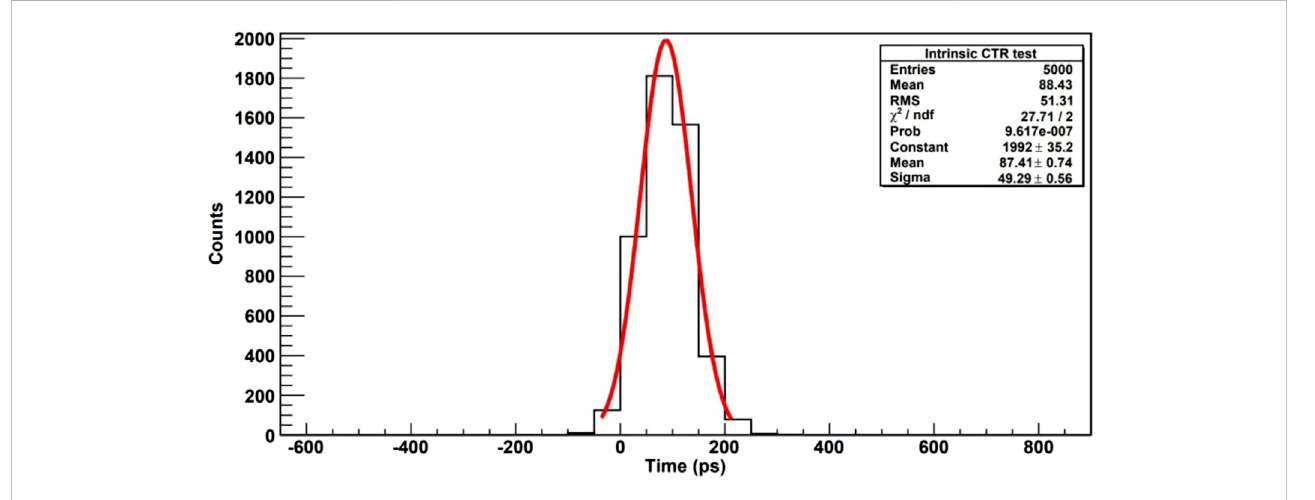
FIGURE 11 Intrinsic CTR spectrum of the